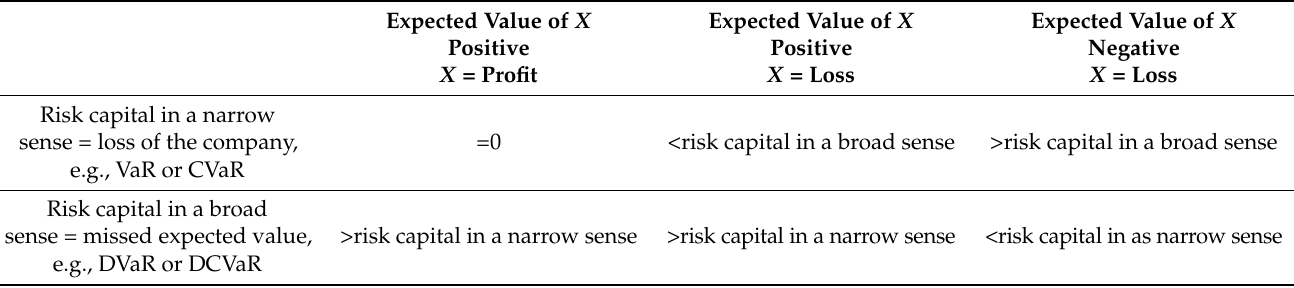
Table 1. Constellations between risk capital in a narrow sense and risk capital in a broad